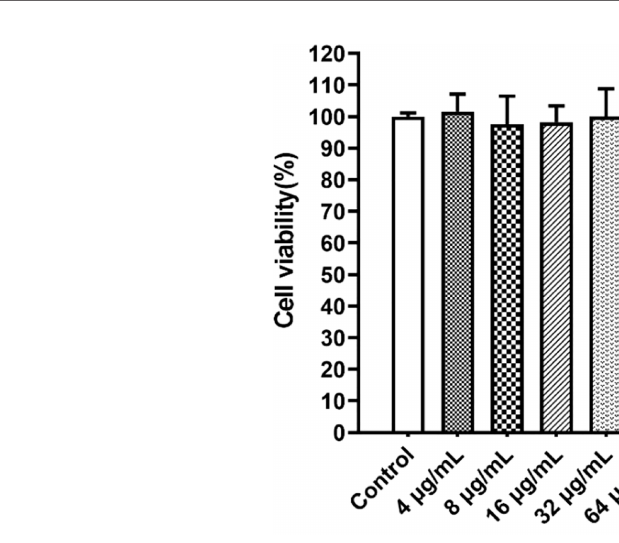
FIGURE 1 | The CCK8 assay was used to determine the cytotoxicity of paeonol on RAW264.7 cells. All data were expressed as means ± SD (n=3). ** P < 0.01 vs the control